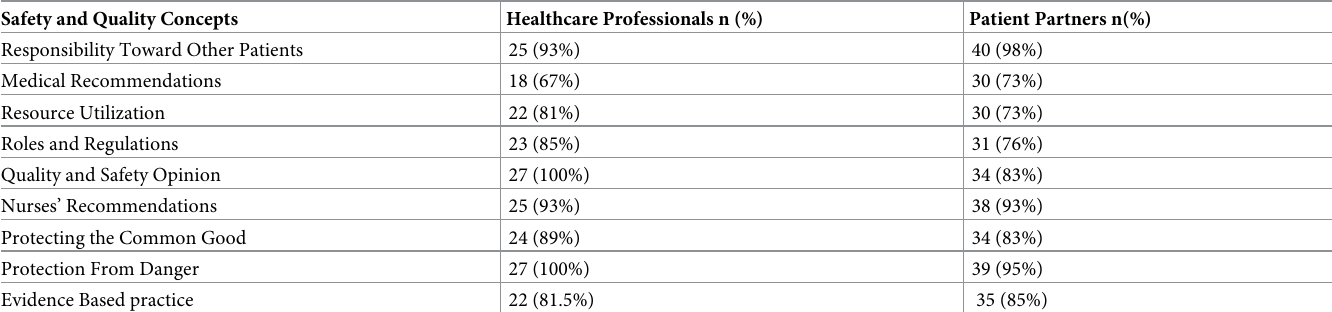
Table 3. The autonomy boundaries of decision-making compared between healthcare professionals and patient partners. Safety and Quality